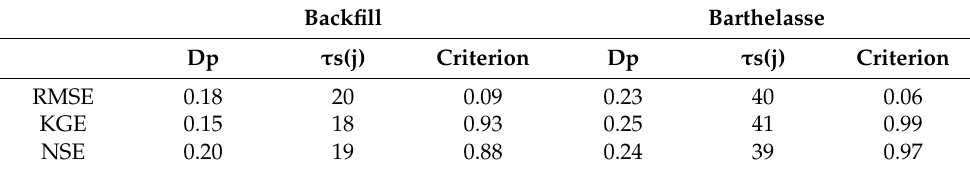
Table 2. Main results of the LPMs applied to the backfill and the pumping field.